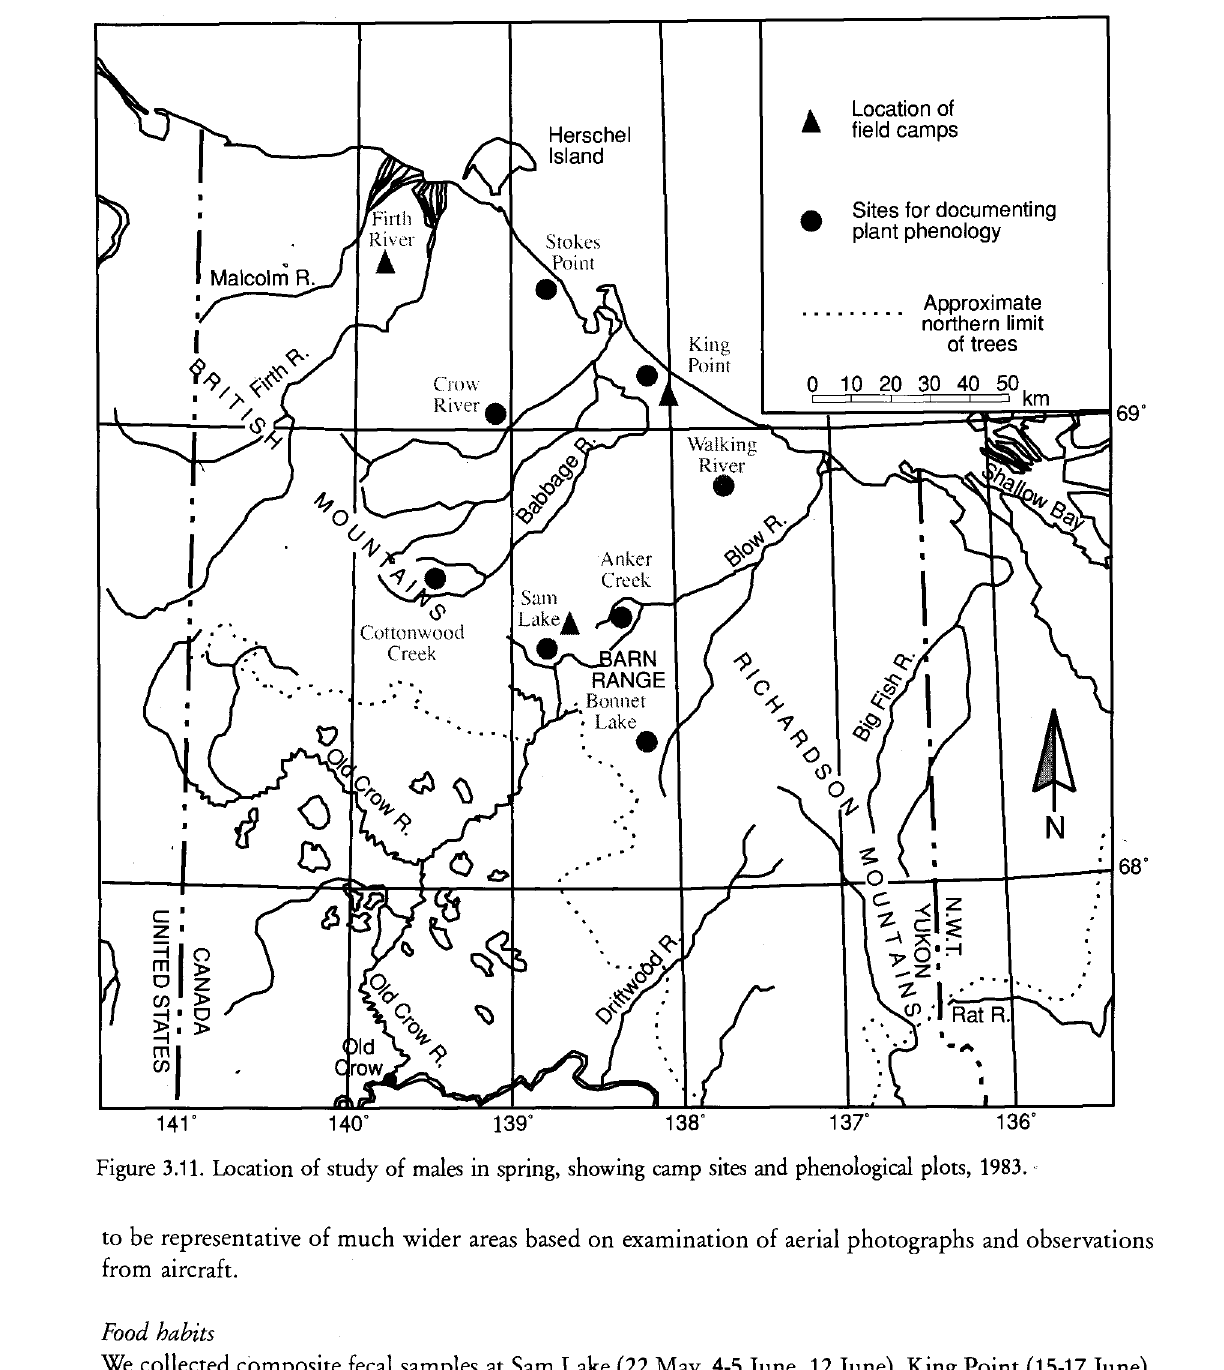
Figure 3.11. Location of study of males in spring, showing camp sites and phenological plots,